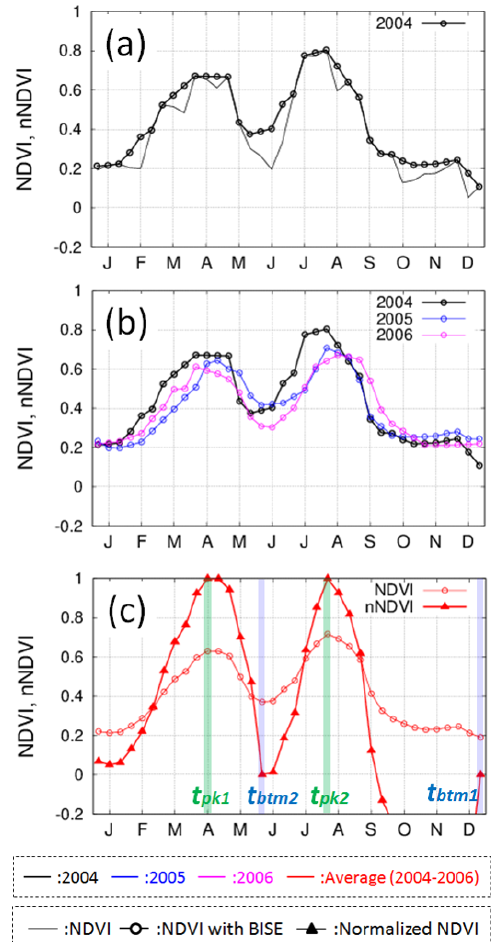
Figure 3. Time series of the NDVI at a double-cropping pixel in China (116.76 ◦ E, 32.60 ◦ N). (a) represents the original NDVI and the NDVI with the BISE correction. (b) represents the NDVI with the BISE correction from 2004 to 2006. (c) represents the NDVI average over 2004–2006 and the normalized NDVI